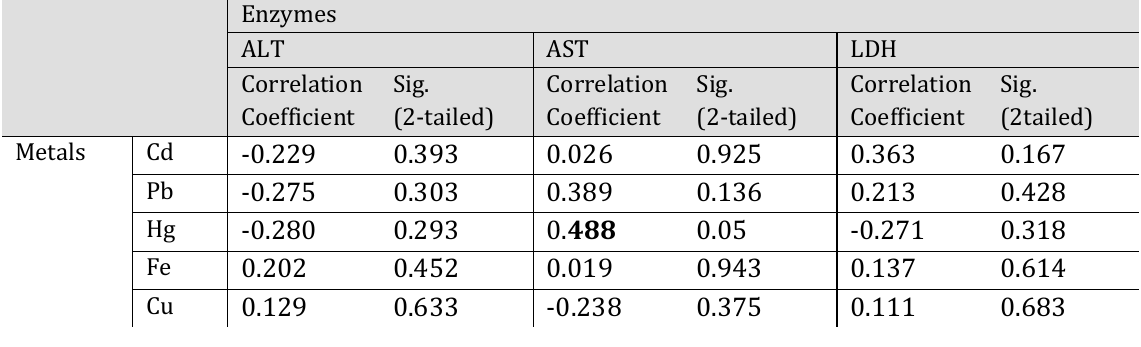
Table 6. Pearson's correlations between Cd, Pb, Hg, Fe, and Cu with liver enzymes (ALT, AST, LDH) in Umm Hufayan.